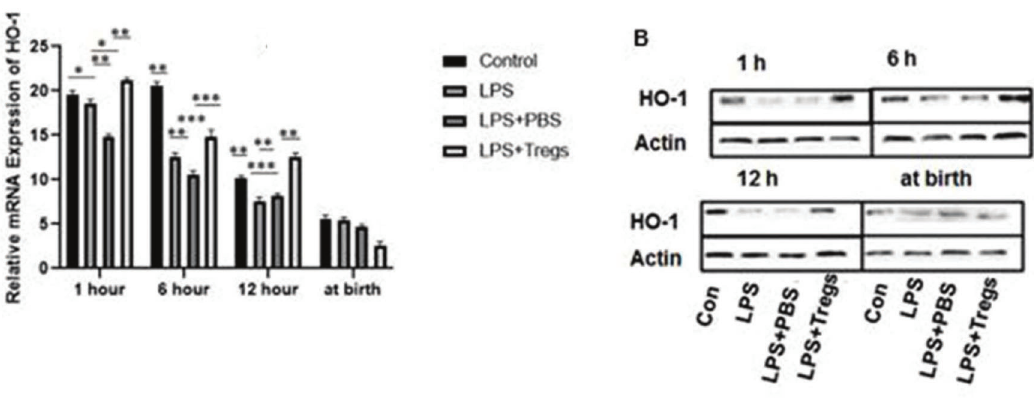
Figure 3 - (A) In liver tissues, HO-1 expression after different treatments was measured via qRT-PCR. The differences were significant per the following criteria: * p o 0.05, ** p o 0.01 and *** p o 0.001. (B) HO-1 expression was decreased at birth in all groups, as examined by western blotting.